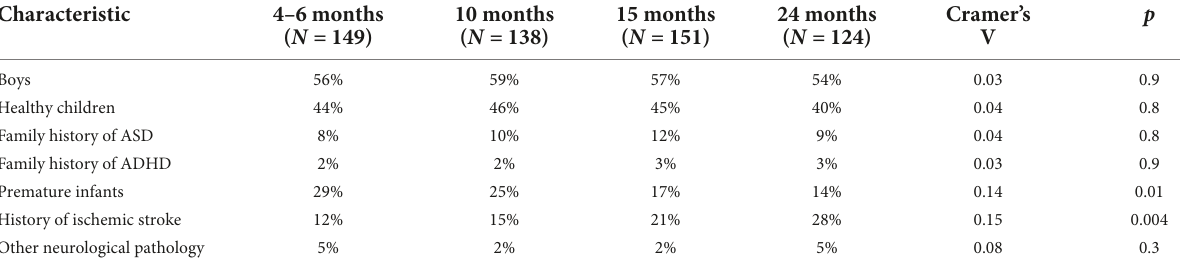
TABLE 1 Clinical and demographic characteristics of the examined